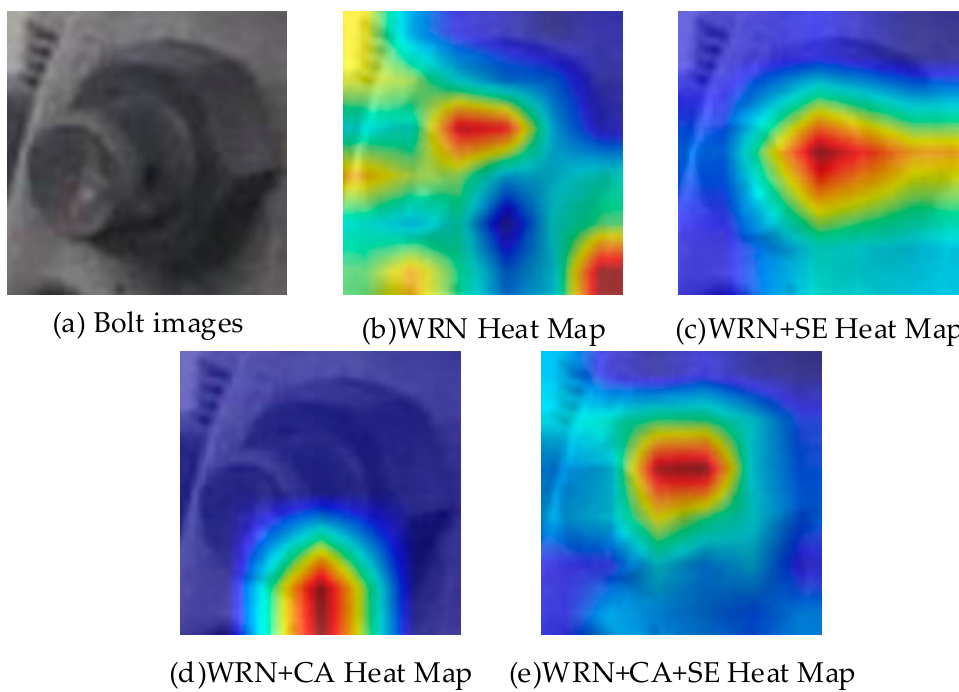
Figure 8. Visualization of the bolt feature map.